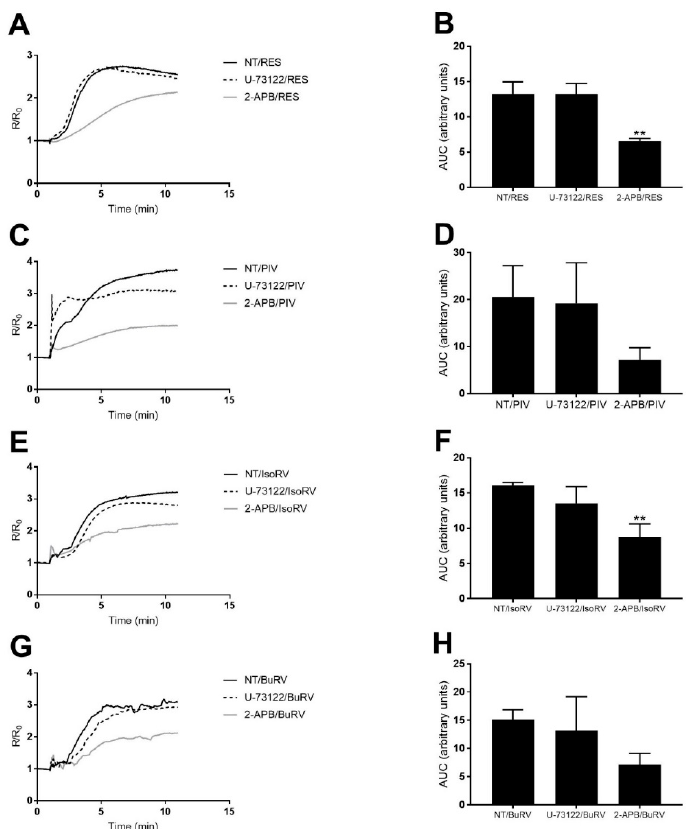
Figure 7. RES and RES derivatives activate calcium release from the IP 3 R independent of phospholipase C (PLC). To determine the source of calcium that leads to the increase in [Ca 2+ ] i , MDA-MB-231 cells were pretreated with a PLC or an IP 3 R inhibitor, U-73122 (black dash) and 2-APB (solid gray), respectively. Cells were loaded with Fura-2 and pretreated with the indicated inhibitor for 10 min prior to treatment with RES ( A , B ); PIV ( C , D ); IsoRV ( E , F ); or BuRV ( G , H ). Cells pretreated with inhibitors and RES derivatives were compared to cells treated only with RES derivatives (solid black). Three biologic replicates are represented by a time trace ( A , C , E , G ) of average response during 10 min of data collection, and changes in [Ca 2+ ] i are quantified by the area under the curve ( B , D , F , H ). ** indicates p < 0.01 compared to no pretreatment with the inhibitors.